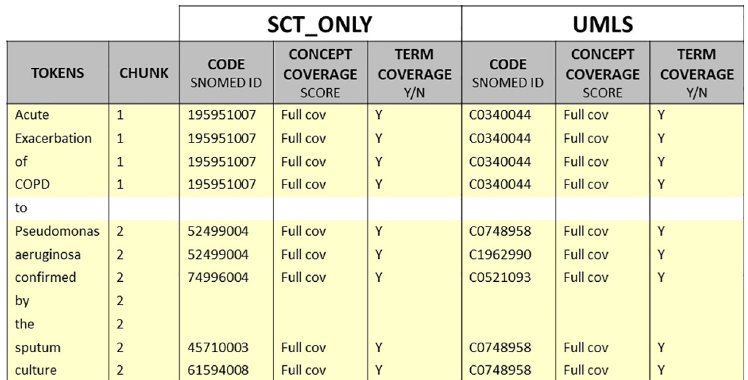
Fig 1. Fragment of an annotation spreadsheet. It shows the header of the document and an example of the annotation of two chunks with SNOMED CT (SCT ONLY) and UMLS terminology settings.